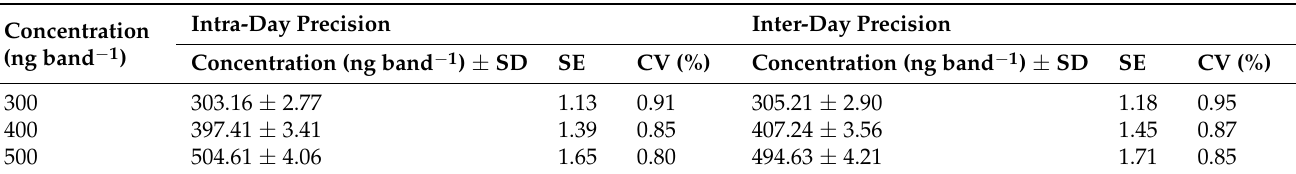
Table 4. Measurement of CIN precision for the present approach (mean ± SD; n = 6).